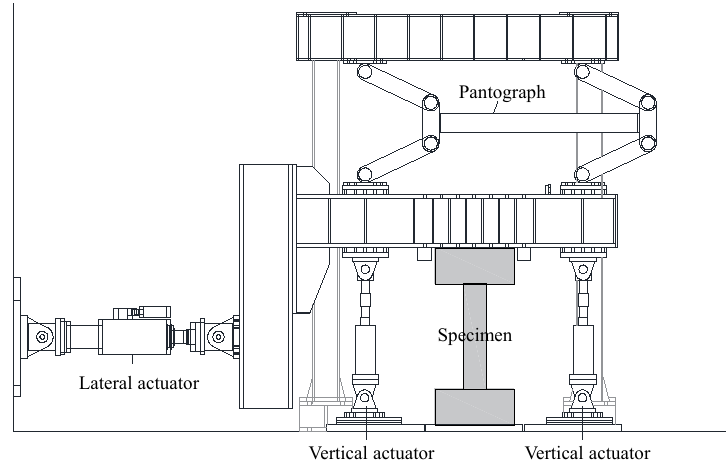
Figure 3. Test setup (example of CM11).